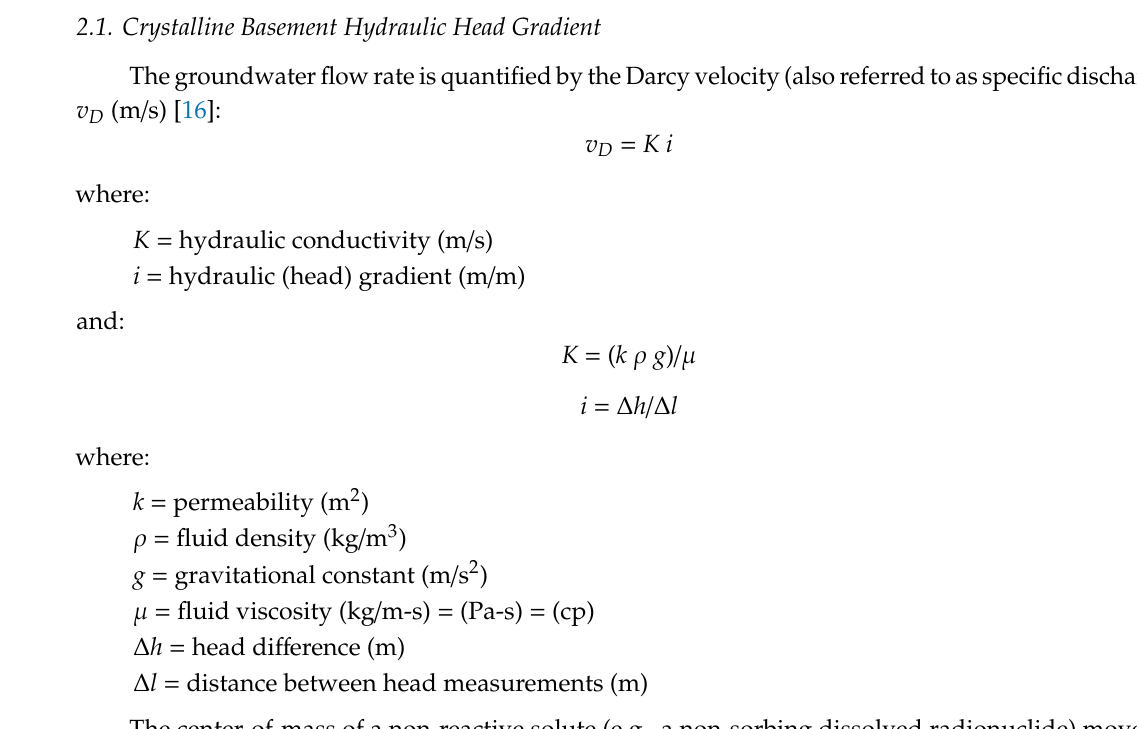
Figure 4. Schematic of the DBD stuck package scenario. Source: Freeze et al. [5].